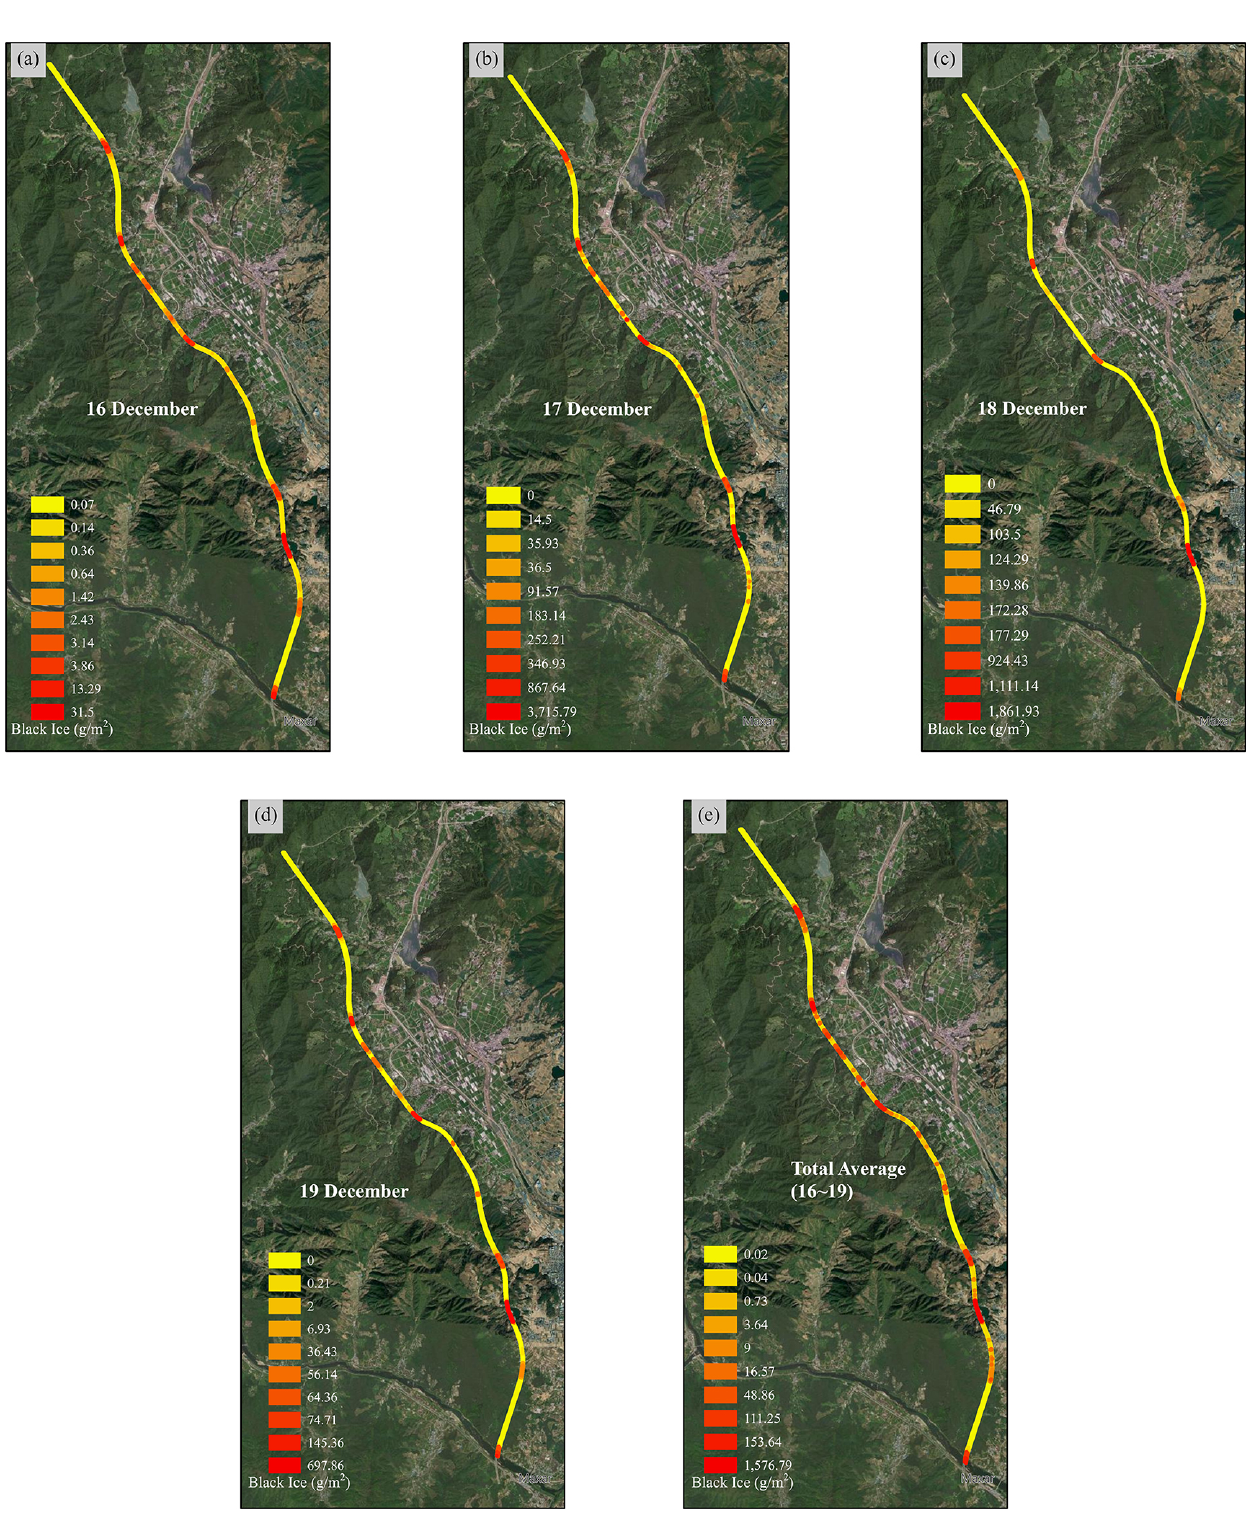
Figure 9. Simulation of black ice occurrence prediction results of system dynamics in units of square metres in the GIS. Panels (a–d) show the amount and location of black ice from 16–19 December. (e) The average of the amount and location of black ice from 16–19 December (source: Esri, Maxar, Earthstar Geographics, and the GIS user